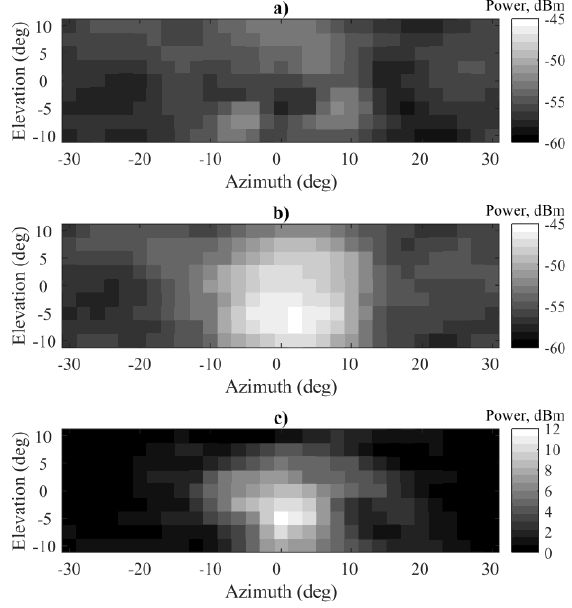
Fig. 10. Background image of the corridor in the radiolight (a), the image of the cube behind the wall in the radiolight (b), the differential image